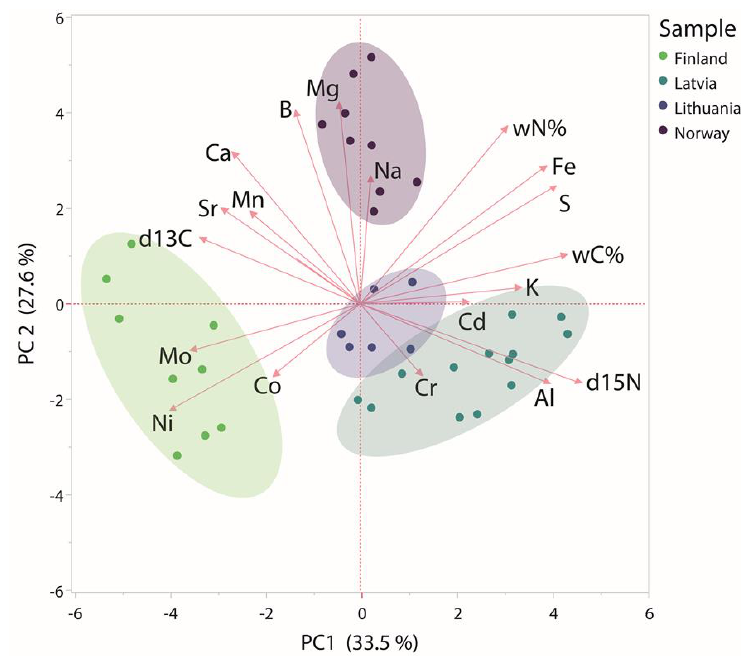
Figure 5. Principal component analysis of metal and light stable isotope contents in bilberries harvested in the Baltic Sea region and Norway ( n = 9). Ellipses represent 95% confidence intervals.